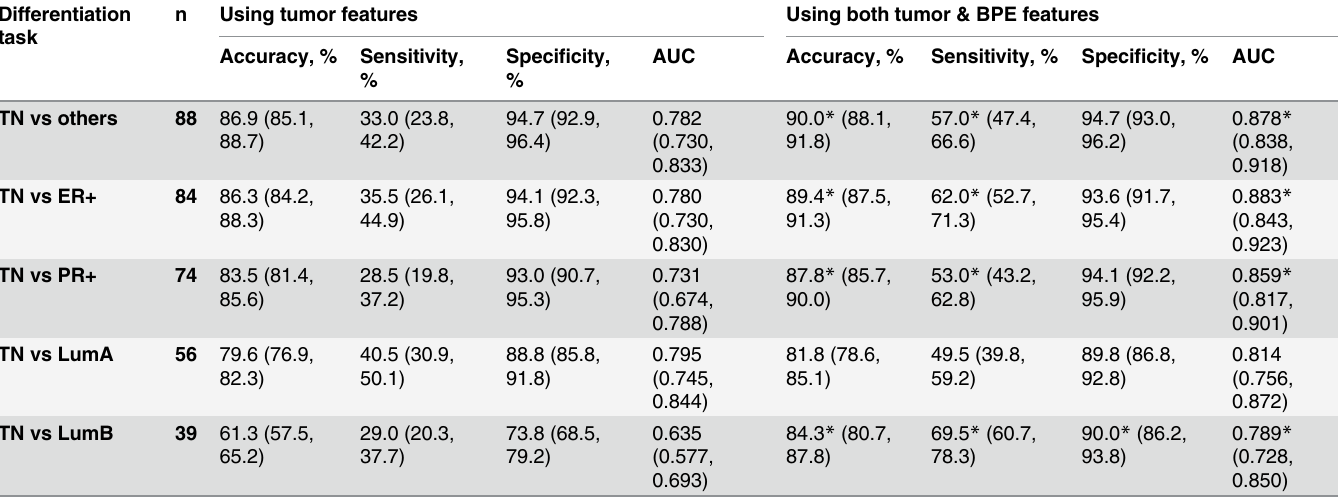
Table 2. Performance results of predictive modeling. Differentiation